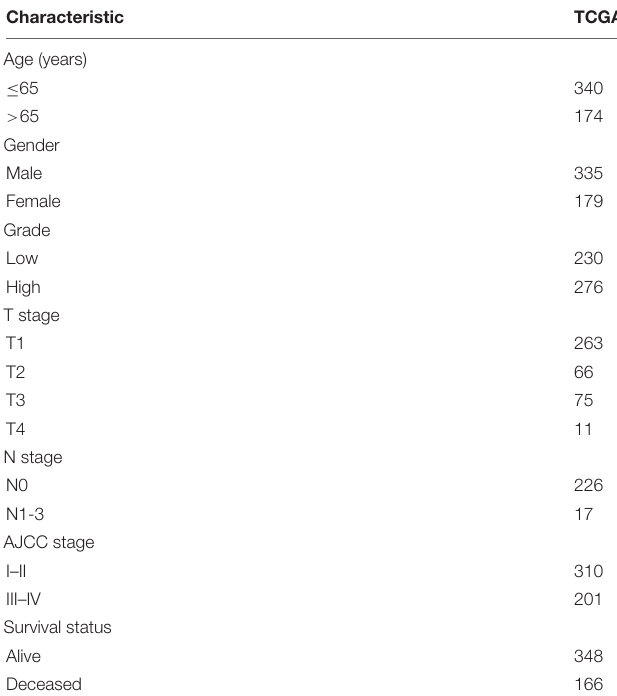
TABLE 1 | Summary of baseline clinical characteristics of patients with renal